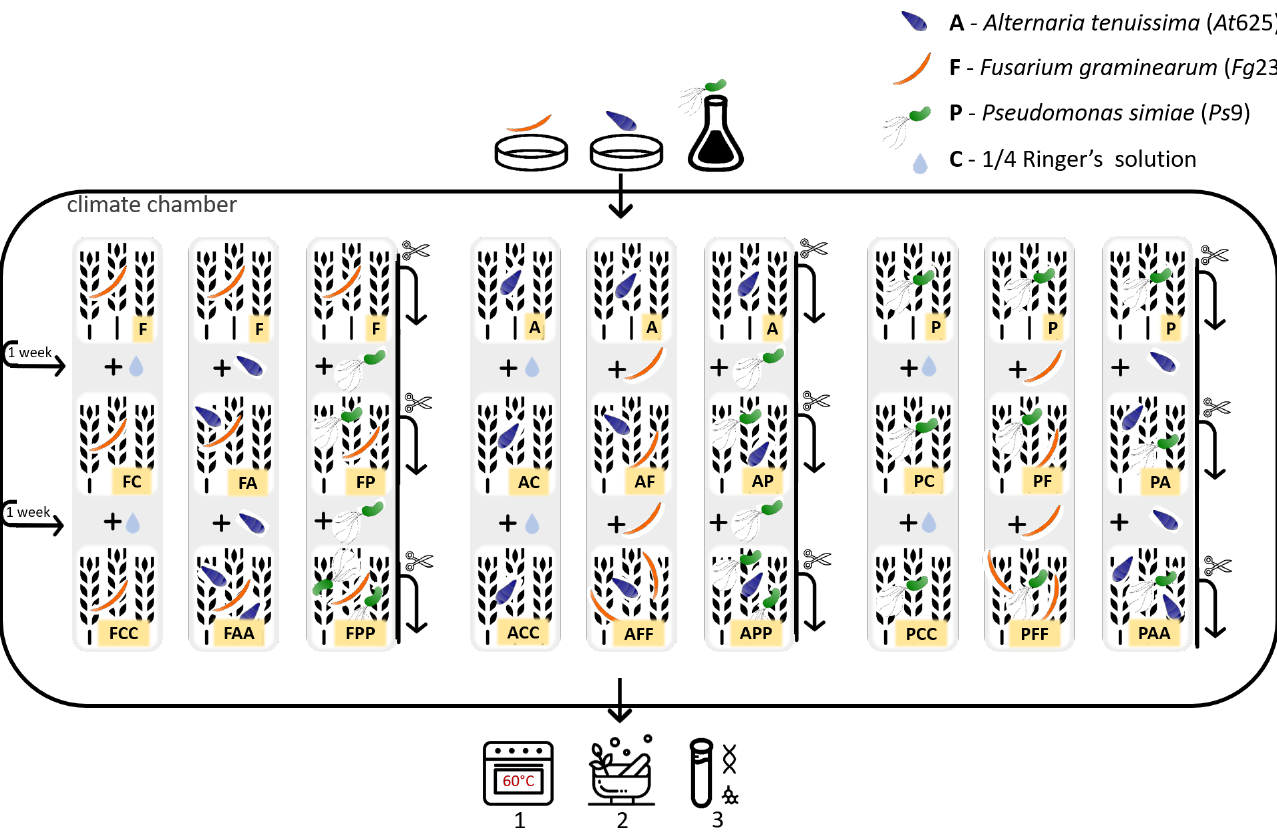
Figure 1. Experimental implementation - flow chart shows the inoculation process over three weeks. Corresponding symbols represent the inoculations with At 625, Fg 23 and Ps 9. Suspensions were obtained from plates (for fungi) and liquid culture (for Ps 9). As control inoculation, 1/4 sterile Ringer’s solution was applied. In the first week, only one isolate was applied to the wheat-ears. In the second week, an additional isolate different from the first one was applied. In the third week, the inoculation of the second week was repeated. Before each new inoculation, a part of the previous variant was harvested. All harvested wheat-ears were dried (1) and ground (2) before further analysis (3). The yellow highlighted box in the lower right corner shows the sample ID: with C=control with 1/4 sterile Ringer’s solution; A= Alternaria tenuissimaAt 625, F= Fusarium graminearumFg 23, P= Pseudomonas simiaePs